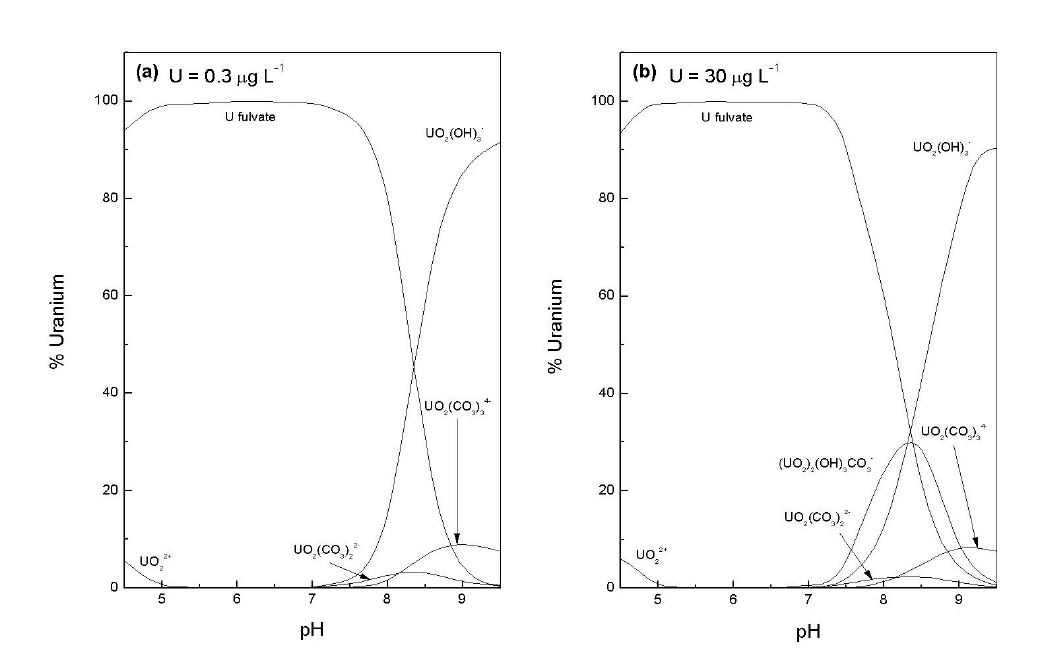
FIGURE 2. Predicted speciation (% distribution) of U as a function of pH (4.5 to 9.5) for a model freshwater at (a) 0.3 (cid:181)g U l -1 and (b) 30 (cid:181)g U l -1 with HS (4.2 mg l -1 fulvic acid; 4.5 mg l -1 dissolved organic carbon). U species <2% are excluded for clarity. U speciation was calculated using HARPHRQ and based on the ionic composition of the Hawkesbury-Nepean River, Sydney, Australia[118] (carbonate = 40 mg l -1 ; sulfate = 9.4 mg l -1 ; chloride = 5.1 mg l -1 ; ionic strength = 0.002 M). Stability constants for U at 25 ° C were taken from Markich and